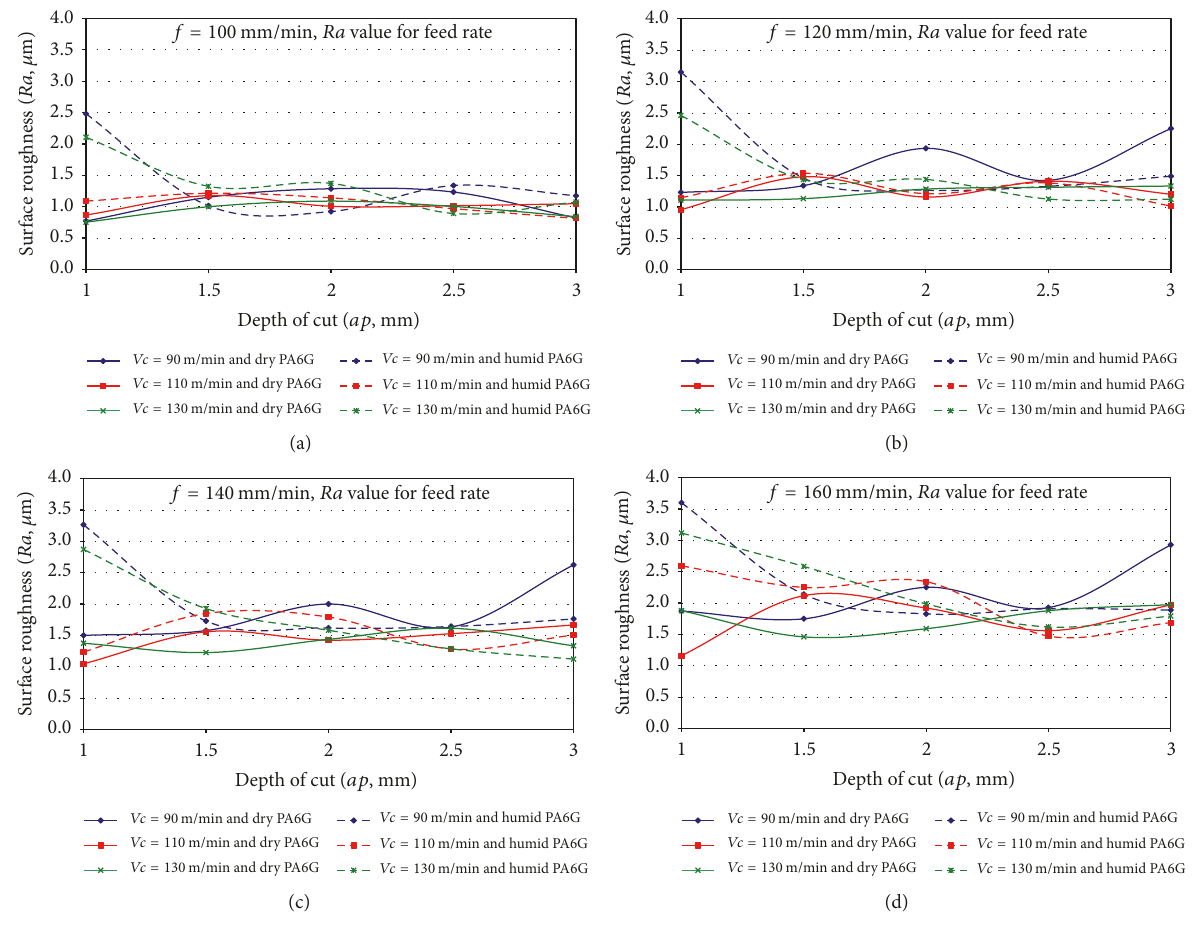
Figure 5: The relationship between surface roughness and depth of the cut for humid and dry samples at different feed rates: (a) 𝑓 = 100mm/min, (b) 𝑓 = 120mm/min, (c) 𝑓 = 140mm/min, and (d) 𝑓 =